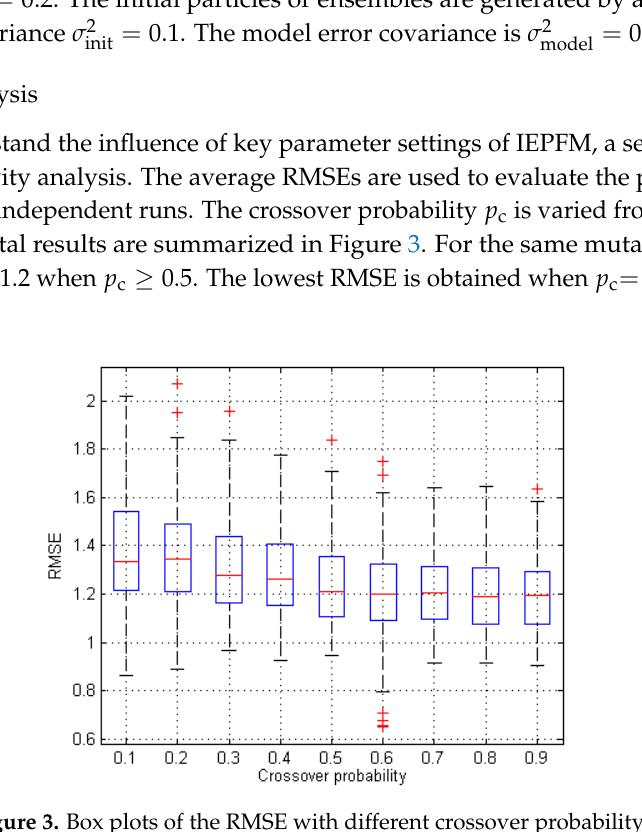
Figure 4. Box plots of the RMSE with different mutation probability. As for the size of the particle set, Figure 5 gives bar plots of the RMSEs and computing time for different ensemble sizes (i.e., 25, 50, 100, 150, and 200) for 30 independent runs. As shown in Figure 5, the RMSE gradually decreases and computing time sharply increases, along with ensemble size becoming larger. It can be found that the performance of IEPFM improves as the ensemble size increases. But the RMSE shows almost no obvious change since N >100. After comprehensive consideration of RMSE and computing time, ensemble size is set to 100 in this study.